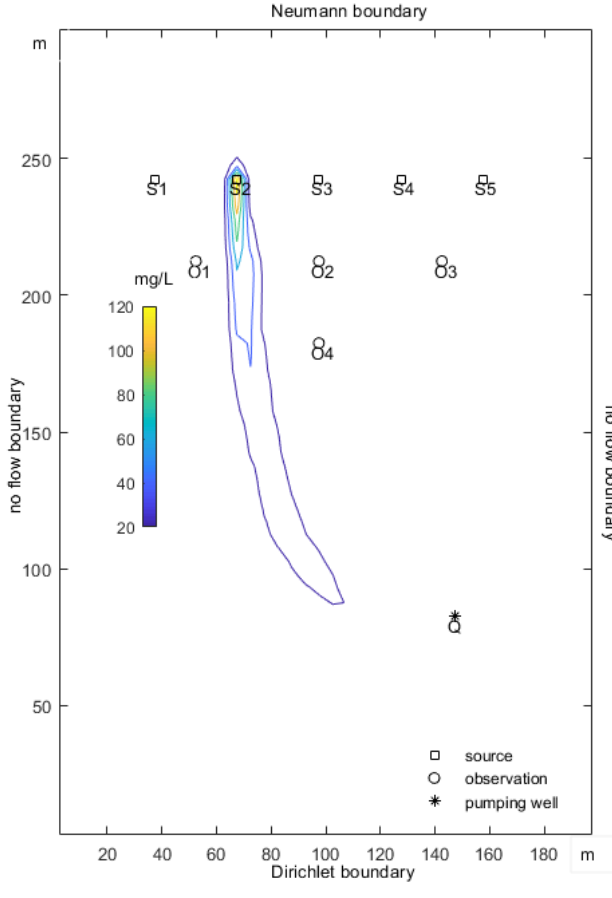
Figure 5. Hypothetical aquifer model for the illustration study. Table 1. Hydrogeological characteristics of the hypothetical